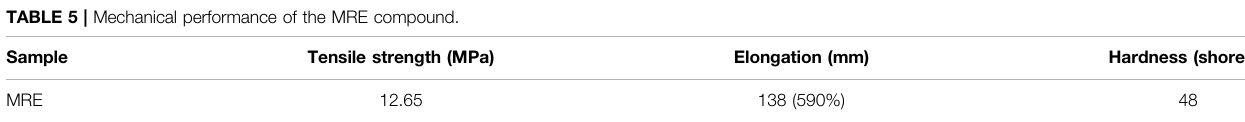
TABLE 5 | Mechanical performance of the MRE